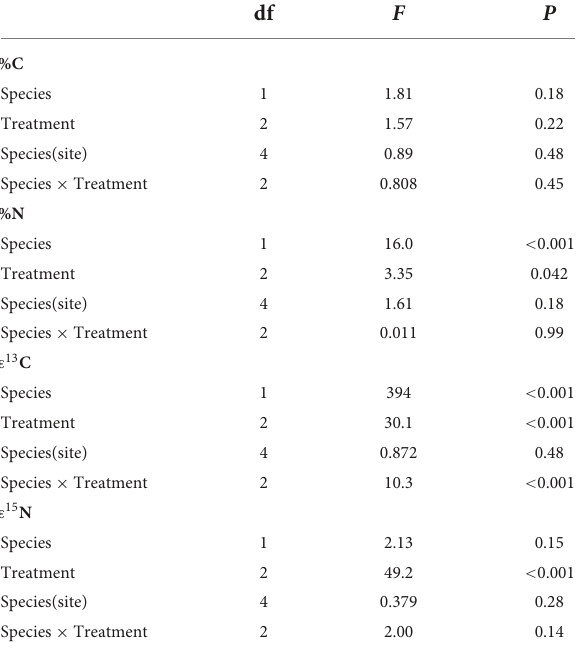
TABLE 3 The results of ANOVA tests for differences in carbon concentration (%C), nitrogen concentration (%N), and enrichment in 13 C and 15 N among orchid species, treatments (drought, shade, and control), sites within species, and species × treatment